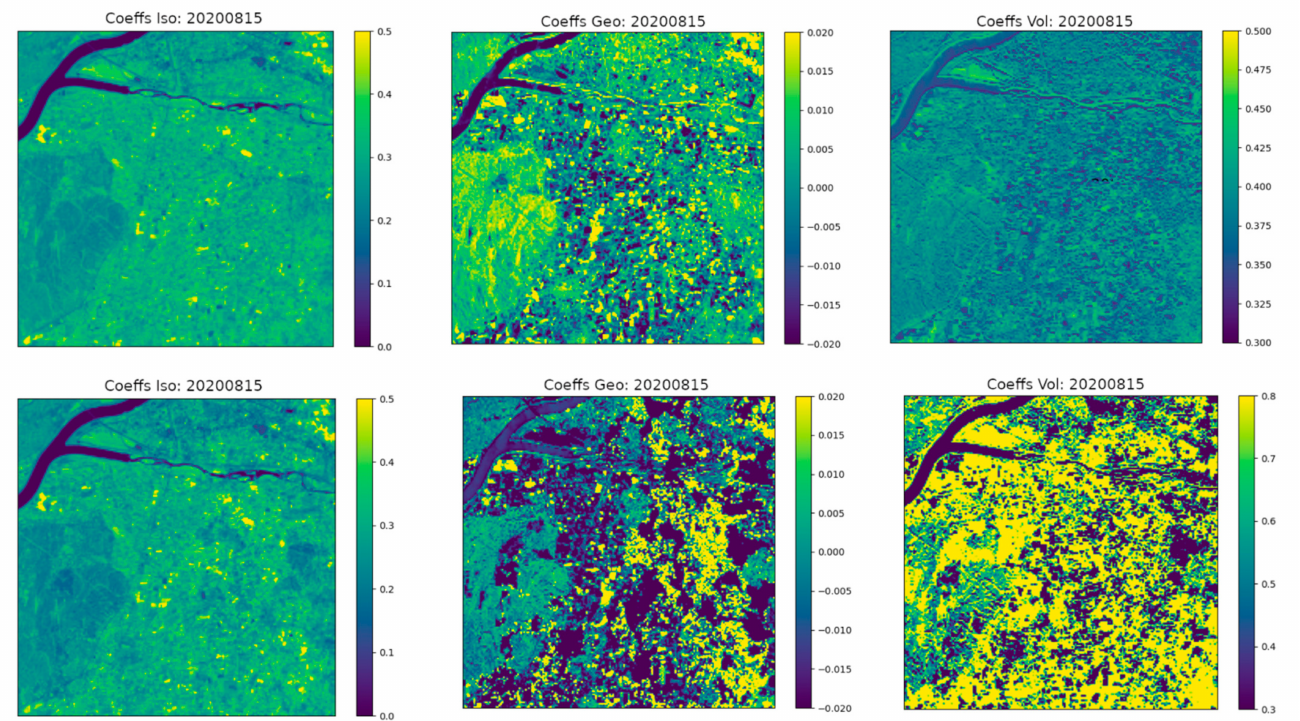
Figure 5. BRDF coefficients k0 (isotropic, top ), k1 (geometric, middle ) and k2 (volume scattering, right ) at La Crau for the S2 B8A image of the 20200815 obtained using the Kalman filter ( top ) and the classical weighted linear inversion ( bottom